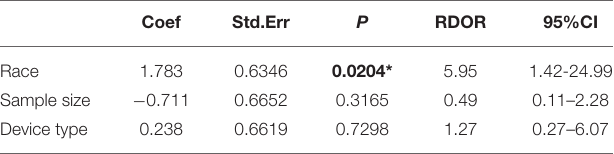
FIGURE 5 | Fagan’s plot.